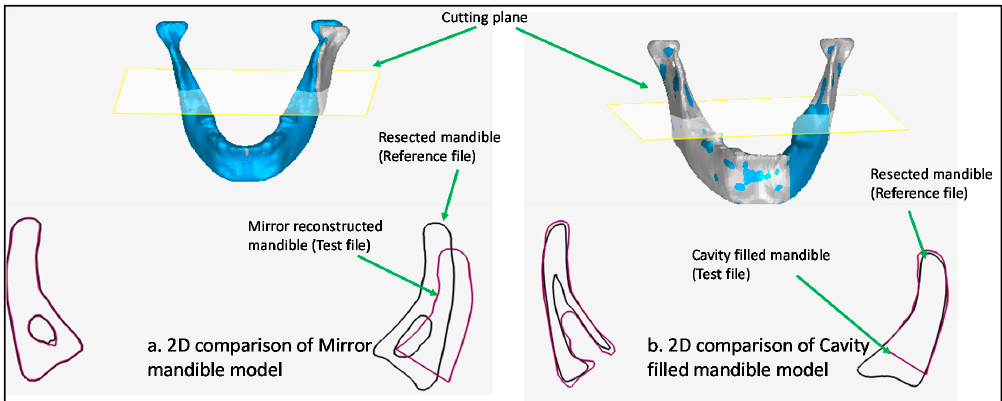
Figure 13. Two-dimensional (2D) comparison results of the cross-sectional plane of resected mandible